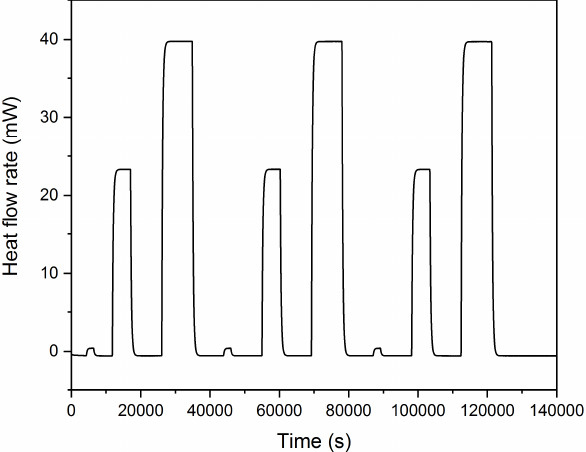
Figure 6. The entropy change versus SOC: ▲ the results from [15], ○ this work, and ■ the results from [16].